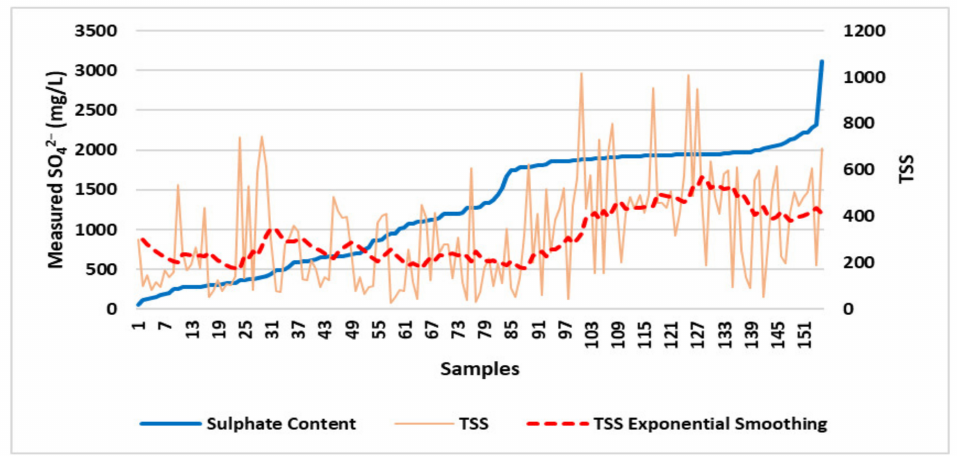
Figure 12. Comparison of Sentinel-2 total suspended solids (TSS) and observed values of SO 42 − content from water analysis.